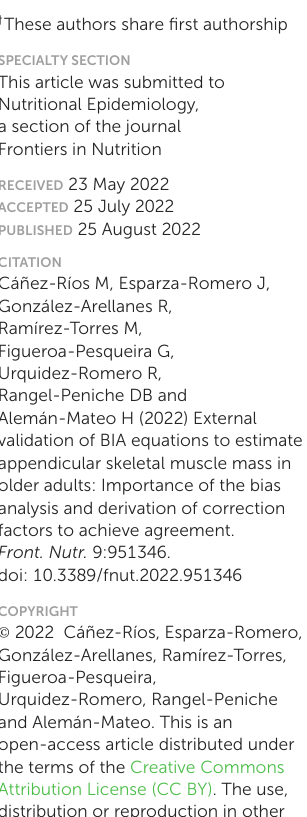
factors to achieve agreement. Front. Nutr.